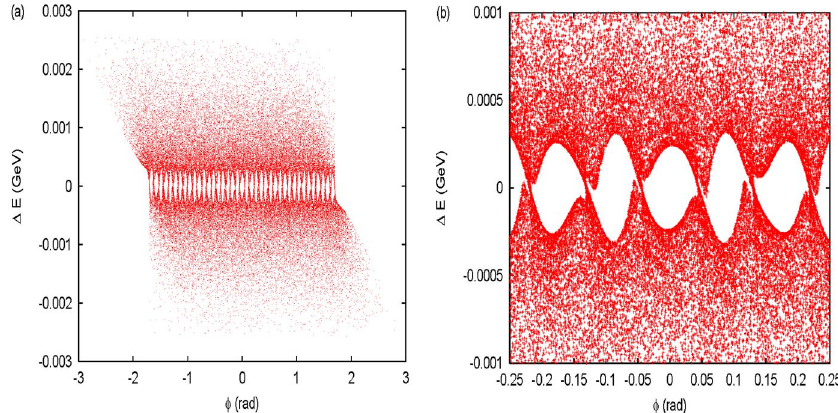
FIG. 6. (Color) (a) Longitudinal phase space of the beam at the end of injection (559 turns) for the chopped beam experiment presented in Fig. 1. (b) Zoom on a smaller portion of the phase space shown in